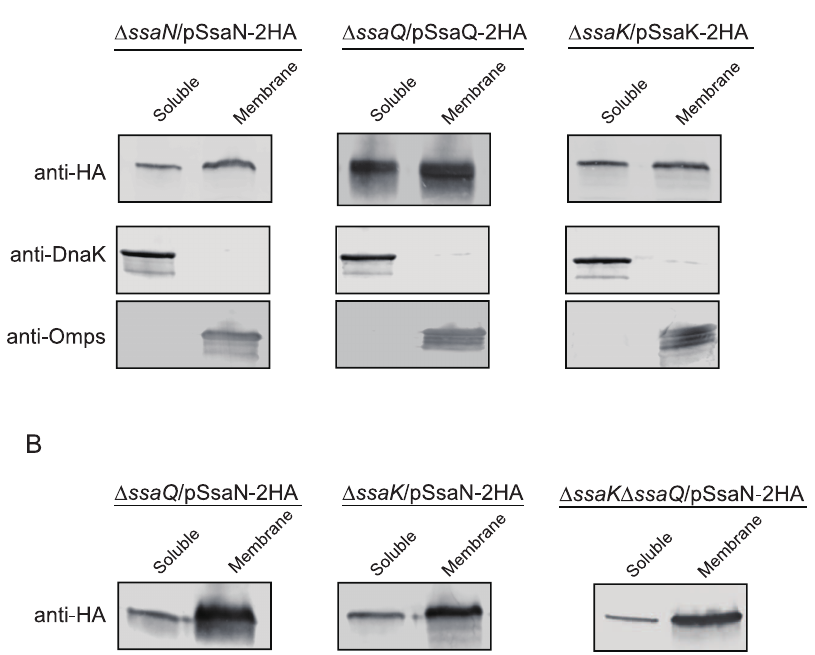
Figure 5. Subcellular localizations of SsaN, SsaK, and SsaQ. SsaN, SsaK, and SsaQ co-localized to bacterial membranes after T3SS activation. Salmonella strains that expressed 2HA-tagged SsaN, SsaK, or SsaQ were grown in LPM (pH 5.8) for 8 h under permissive conditions that induced T3SS-2 secretion, after which bacteria were fractionated into soluble (S) and membrane (M) fractions. These fractions were analyzed by immunoblotting using an antibody against 2HA epitopes. DnaK and outer membrane proteins (Omps) were used as markers for the cytoplasmic and membrane fractions, respectively. ( A ) Localization was examined in the complemented strains. ( B ) Localization of SsaN was examined in ssaQ , ssaK , and ssaKssaQ double mutant strains.